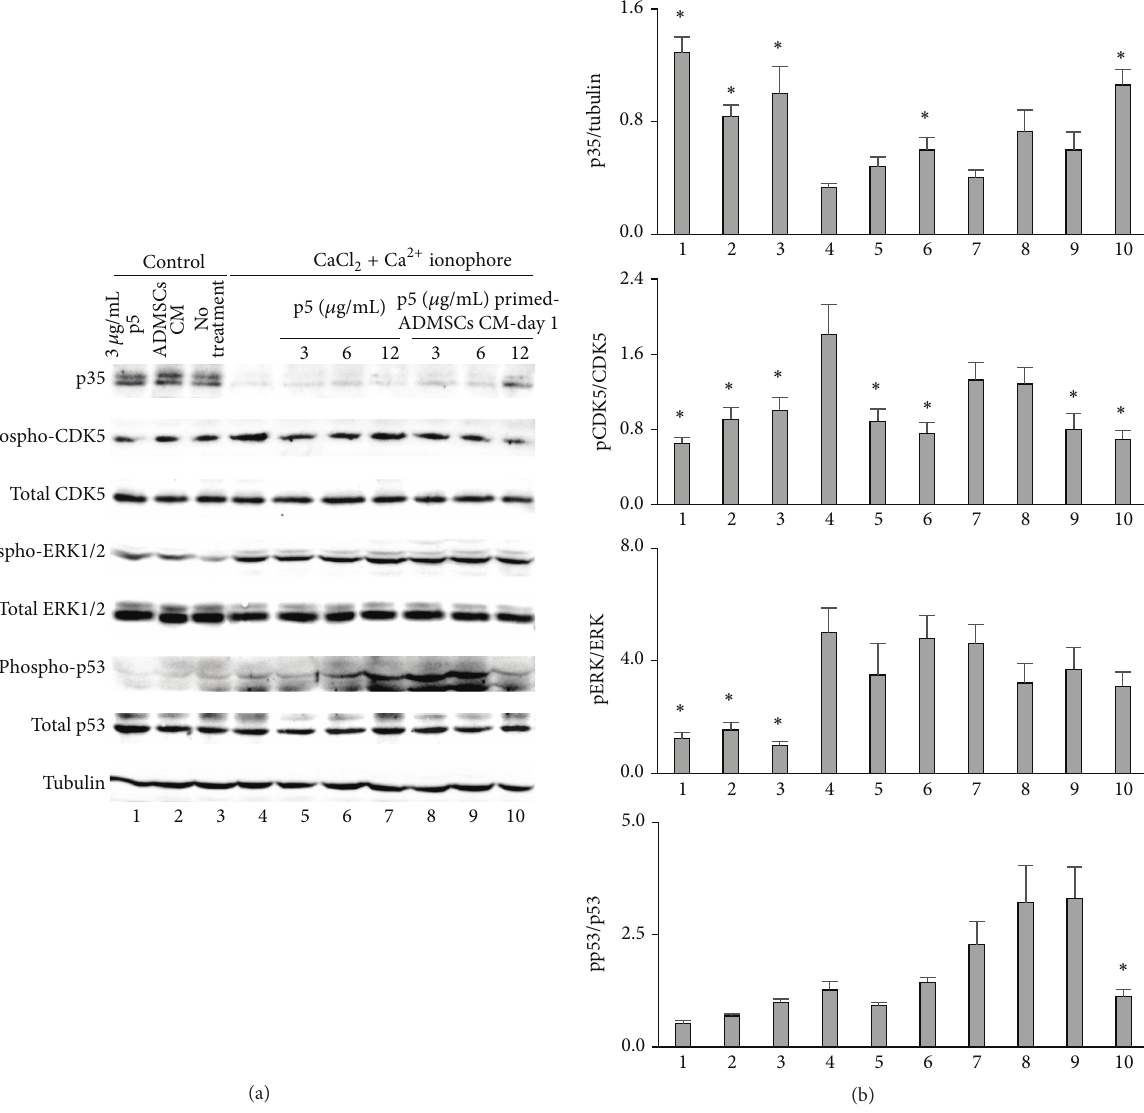
Figure 4: p5 and CM from p5-primed hADMSCs inhibited CDK5 and p53 activation by calpain in cultured BAECs. (a) The cultured BAECs were treated with p5 (lanes 5–7) or conditioned medium (CM) from p5-primed hADMSCs collected on Day 1 (lanes 8–10) for 1 hour and then further treated with 5 𝜇 M calcium ionophore A23187 and 2.5 mM CaCl 2 for 10 minutes. The 3 𝜇 g/mL p5 treatment alone (lane 1), CM from untreated hADMSCs (lane 2) and untreated BAECs (lane 3) were used as control. The p35 cleavage and the phosphorylation of CDK5 and p53 were suppressed by p5 and CM from p5-primed hADMSCs. (b) Densitometric analysis of immunoblots quantification. Data are means ± SD (error bars). Significance (denoted as ∗ ) was calculated compared to cells treated with 5 𝜇 M calcium ionophore A23187 and 2.5 mM CaCl 2 (lane 4) using Student’s 𝑡 -test (with 𝑝 <